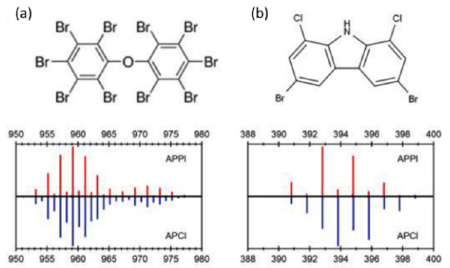
Figure 1. Partial mass spectra obtained using GC–APPI ( top ) and GC–APCI ( bottom ) for ( a ) decabromodiphenylether (BDE-209) and its 13 C-labelled counterpart, and ( b ) 1,8-dibromo-2,6-dichloro-9H- carbazole. Reprinted from Di Lorenzo et al. [68]. Copyright 2019, with permission from